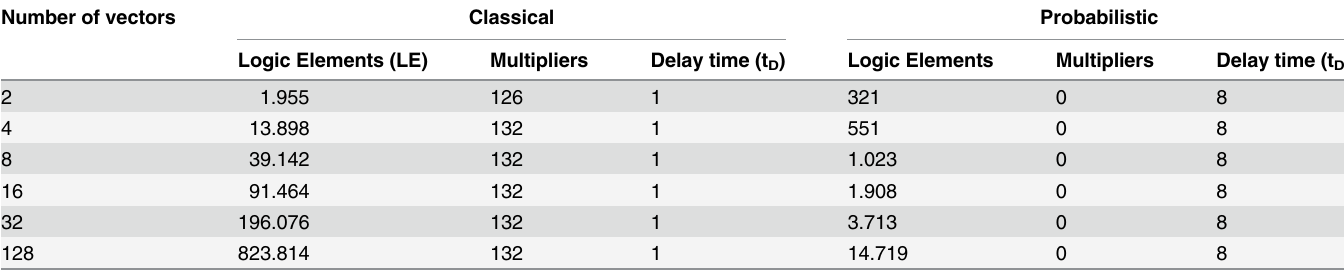
Table 2. Relationship between conventional and probabilistic implementation in terms of FPGA resources for an Altera Cyclone III device. Number of vectors Classical Probabilistic Logic Elements (LE) Multipliers Delay time (t D ) Logic Elements Multipliers Delay time (t D